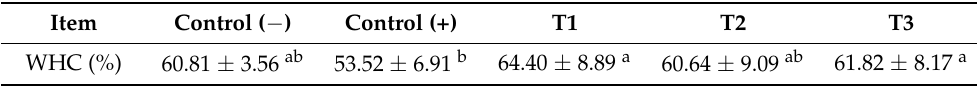
Table 3. WHC of pork patties with fermented soy sauce.